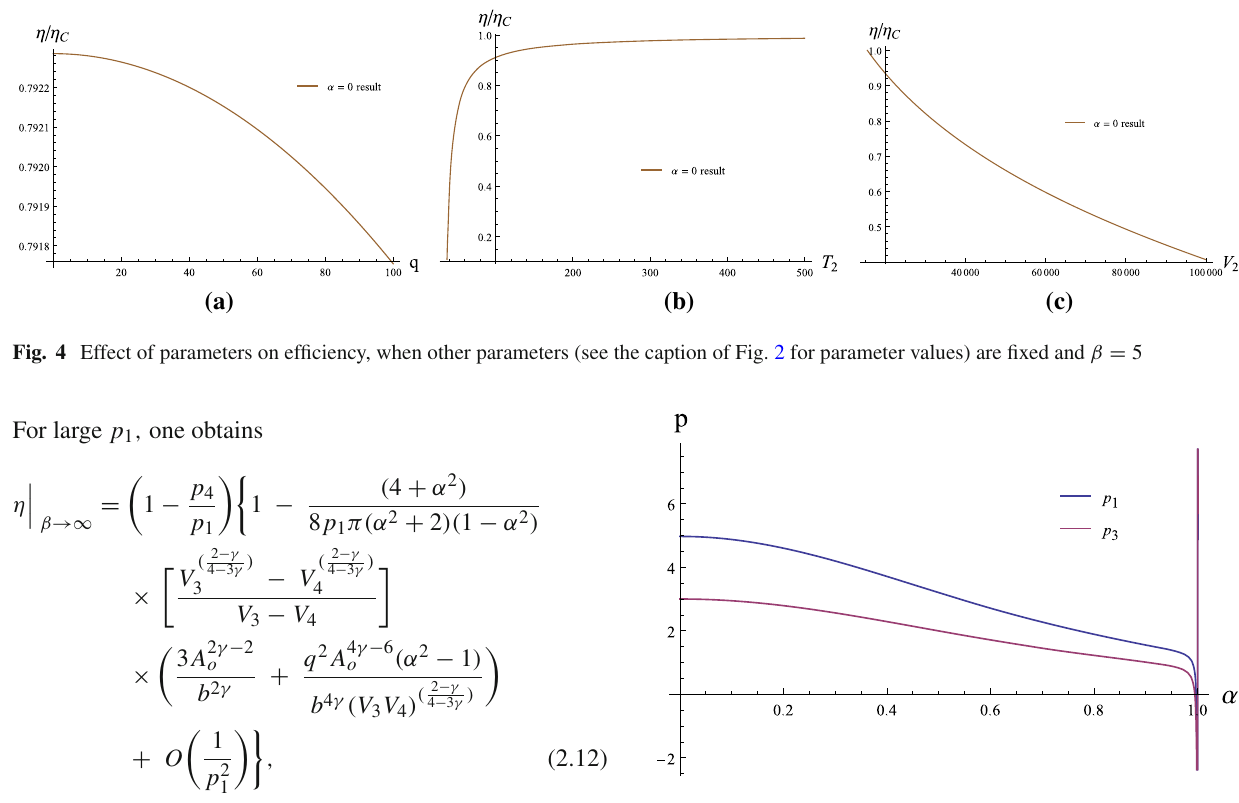
Fig. 5 Inthelimit β → ∞ , physicalrangeofpressures(seethecaption of Fig. 2 for parameter